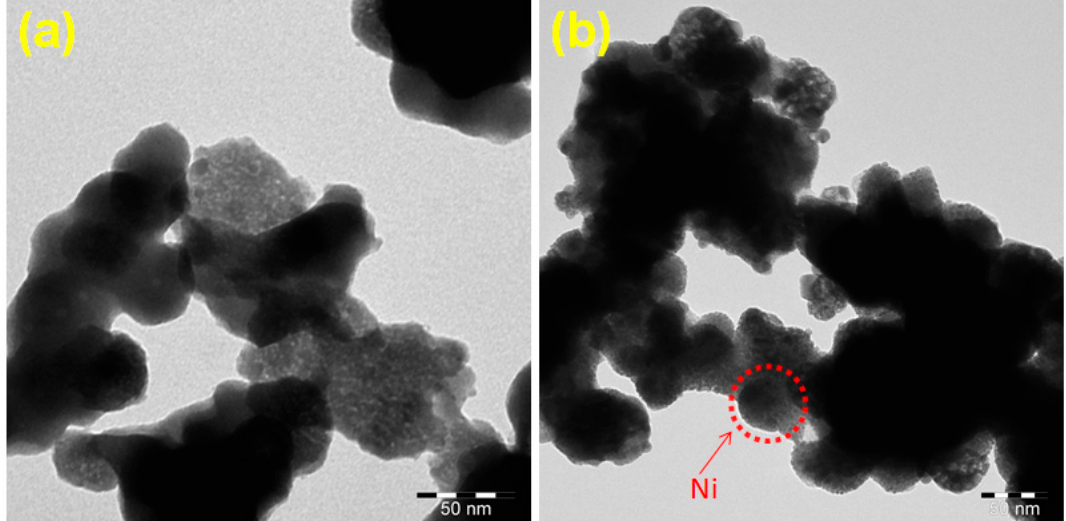
Figure 4. Transmission electron microscopy (TEM) images of ( a ) bare CWO and ( b ) CWO–Ni3.